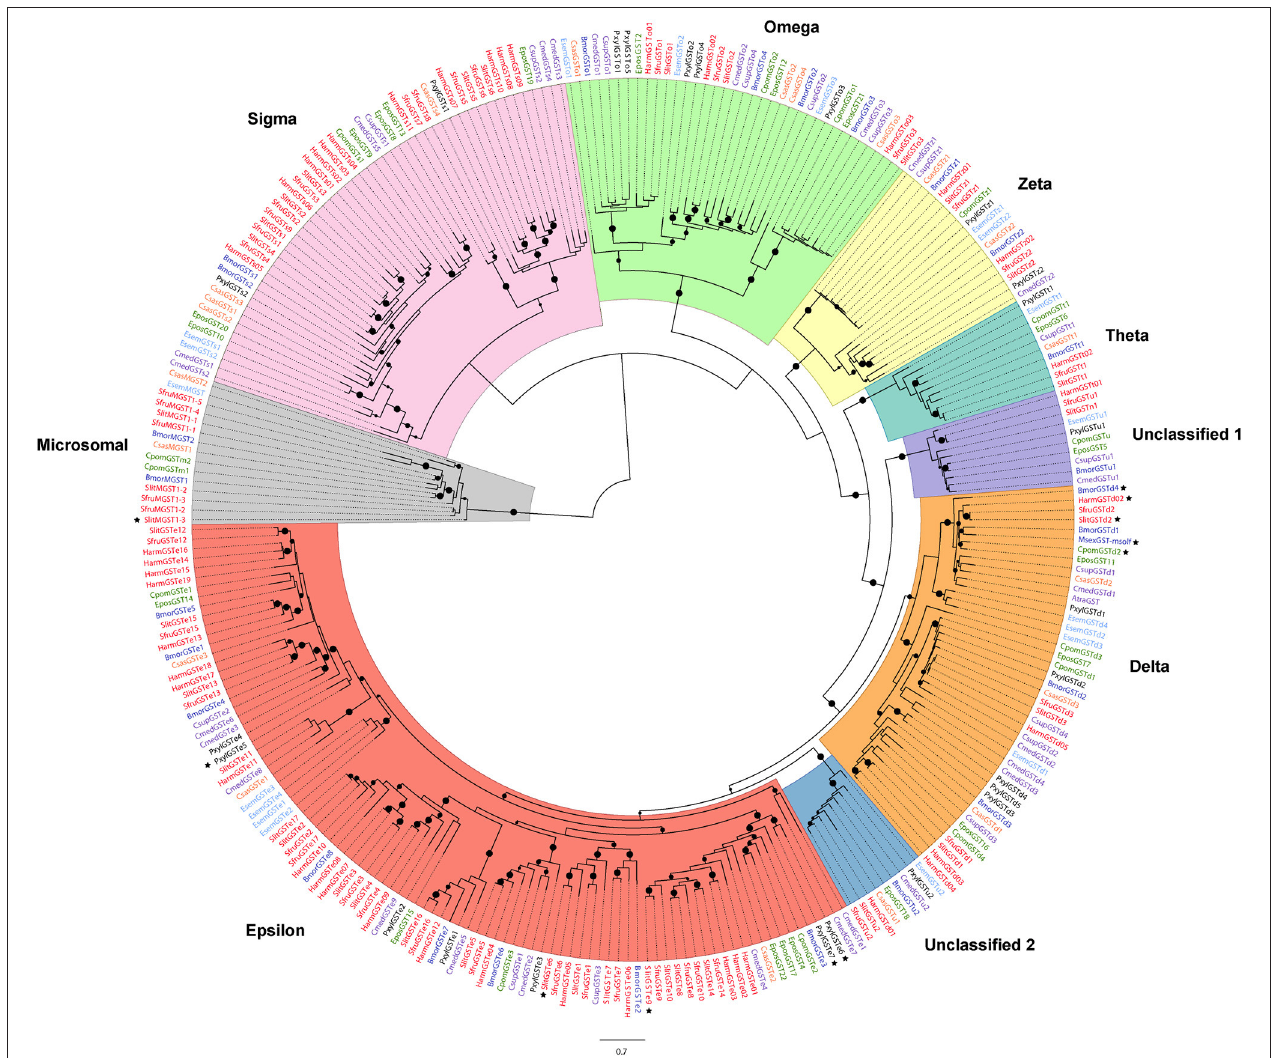
FIGURE 1 | Maximum-likelihood phylogeny of antennal-expressed lepidopteran GSTs. The tree was built from amino-acid sequences of GST repertoires of S. littoralis , S. frugiperda , H. armigera (Noctuidae family, branches colored in red), M. sexta , B. mori (Bombycoidea, dark blue), C. pomonella , E. postvittana (Tortricoidea; green), C. medinalis , C. suppressalis, A. transitella (Pyraloidea, purple), C. sasakii (Carposinidae, orange), P. xylostella (Plutellidae, black), and E. semipurpurella (Eriocraniidae, light blue). The MAPEG clade was used as an outgroup. Circles represent nodes highly supported by the likelihood-ratio test (small dots: aLRT > 0.9, middle dots: aLRT > 0.95, big dots: aLRT = 1). The black stars indicate antennal-enriched or antennal-specific GSTs. The scale bar represents 0.7 expected amino-acid substitutions per